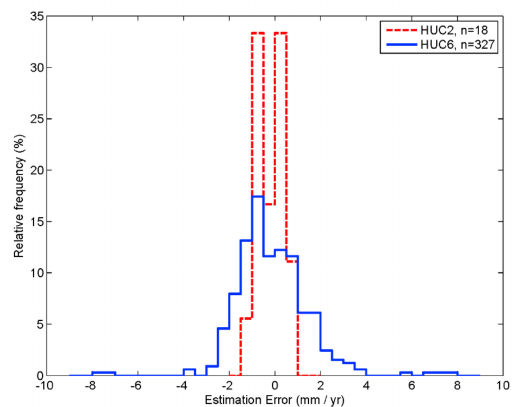
Figure 13. Relative histograms of the estimation errors (i.e., predicted minus observed) in the linear tendencies for the HUC2 and HUC6 annual PRISM precipitation rates (1979–2015).